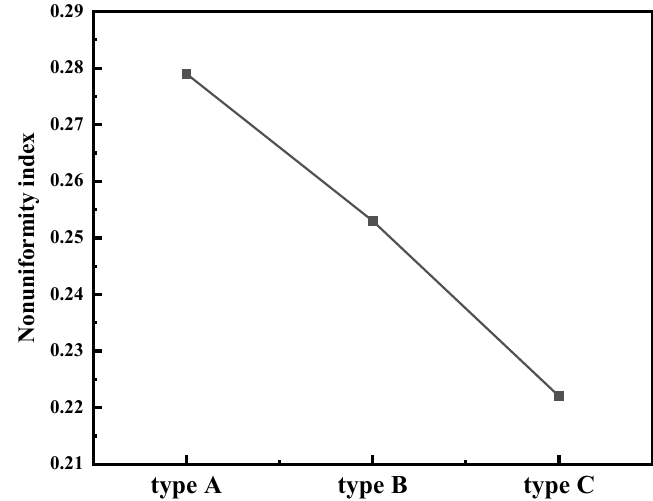
Figure 16. Nonuniformity index of different feeding structures.